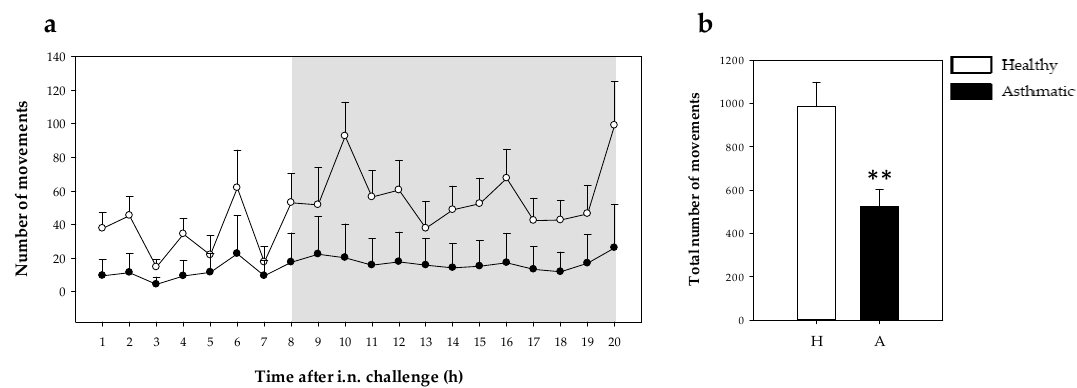
Figure 3. Motor activity during 20 h after the i.n. challenge. ( a ) Motor activity assessed every hour (the shadow period corresponds to darkness) in healthy (H, white symbol) and asthmatic (A, black symbol) rats. Statistical di ff erences not included. ( b ) Total number of movements in healthy (H, white bars) and asthmatic (A, black bars) 20 h after the challenge. Results are expressed as mean ± standard error ( N = 9). Significant di ff erences: ** p < 0.01 vs. healthy